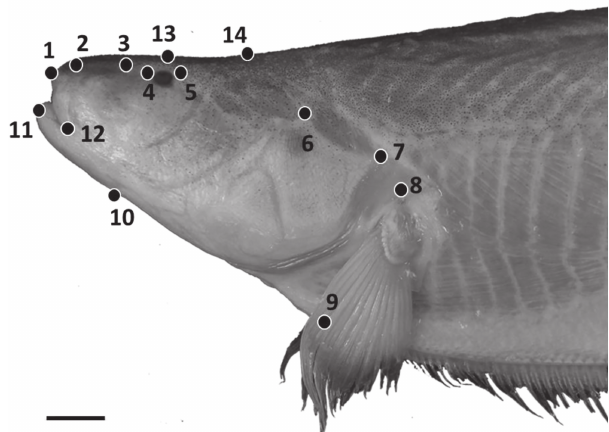
Fig. 1. Positions of 14 homologous landmarks of the head used in geometric morphometric analyses. Photo of Sternarchella orthos (FMNH 115236). Scale bar = 15